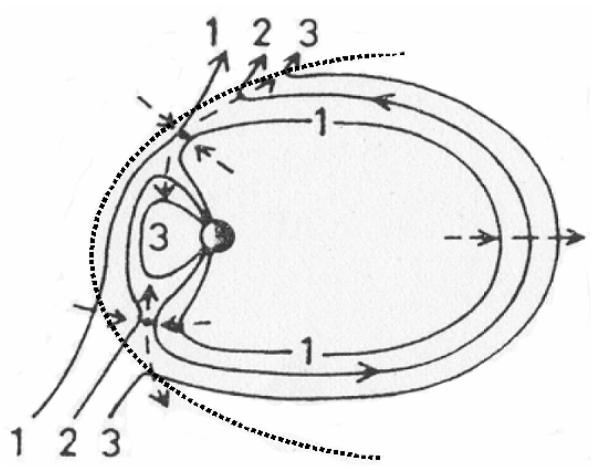
Fig. 1. We have followed Dungey’s (1963) ideas which were later described by Cowley (1983), who represented the sequential merg- Figure 1 . We have followed Dungey’s (1963) ideas which were later described by Cowley ing in the Northern and Southern Hemisphere for the cases of IMF (1983), who represented the sequential merging in the Northern and Southern Hemisphere for B x < 0. We have drawn on Fig. 1e from Cowley (1983) a dotted the cases IMF Bx <0. We have drawn on Figure 1e from Cowley (1983) a dotted curve which curve which indicates the magnetopause. Lobe reconnection first indicates the magnetopause. Lobe reconnection first occurs in the Northern Hemisphere, forming occurs in the Northern Hemisphere, forming an open field line that an open field line that drapes over the dayside and one that connects to the Southern Hemisphere. drapes over the dayside and one that connects to the Southern Hemi- Later, the overdraped field line merges with one of the previously opened field lines in the sphere. Later, the overdraped field line merges with one of the pre- Southern Hemisphere, forming a closed dayside field line and a completely detached IMF field viously opened field lines in the Southern Hemisphere, forming a line (see also Belenkaya (1998a,b)). closed dayside field line and a completely detached IMF field line (see also Belenkaya, 1998a,